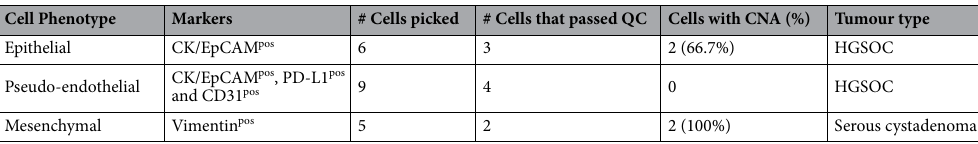
Table 1. Selected cell phenotype and CNV